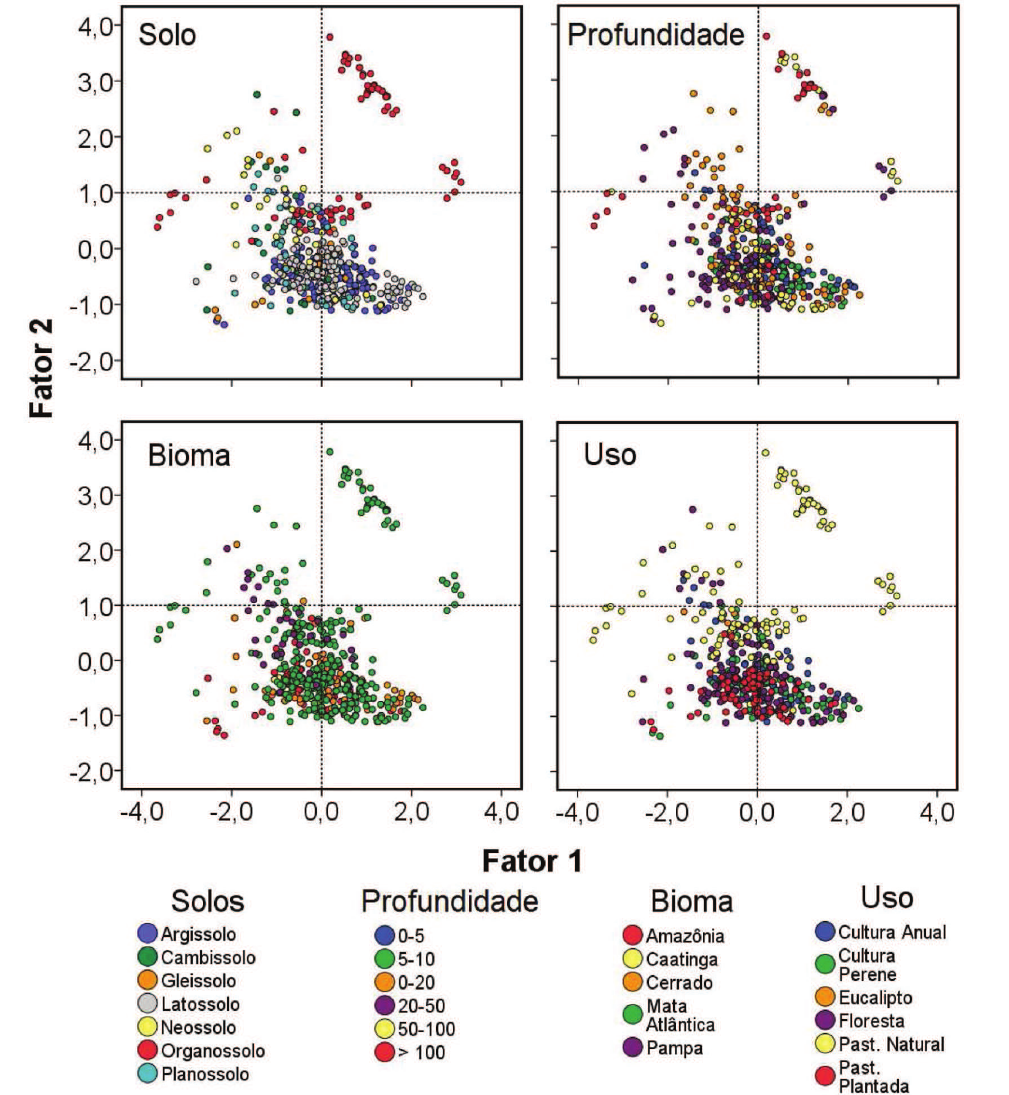
Figura 3. Escores das frações percentuais das SHs e dos teores de COT pela análise de componentes principais, estratificados por profundidade, bioma, ordem de solo e uso do solo.